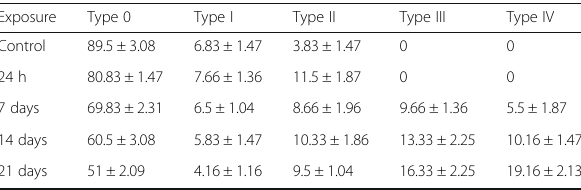
Table 4 Nucleoids in various damage degrees in the blood of C. carpio on exposure to karanjin